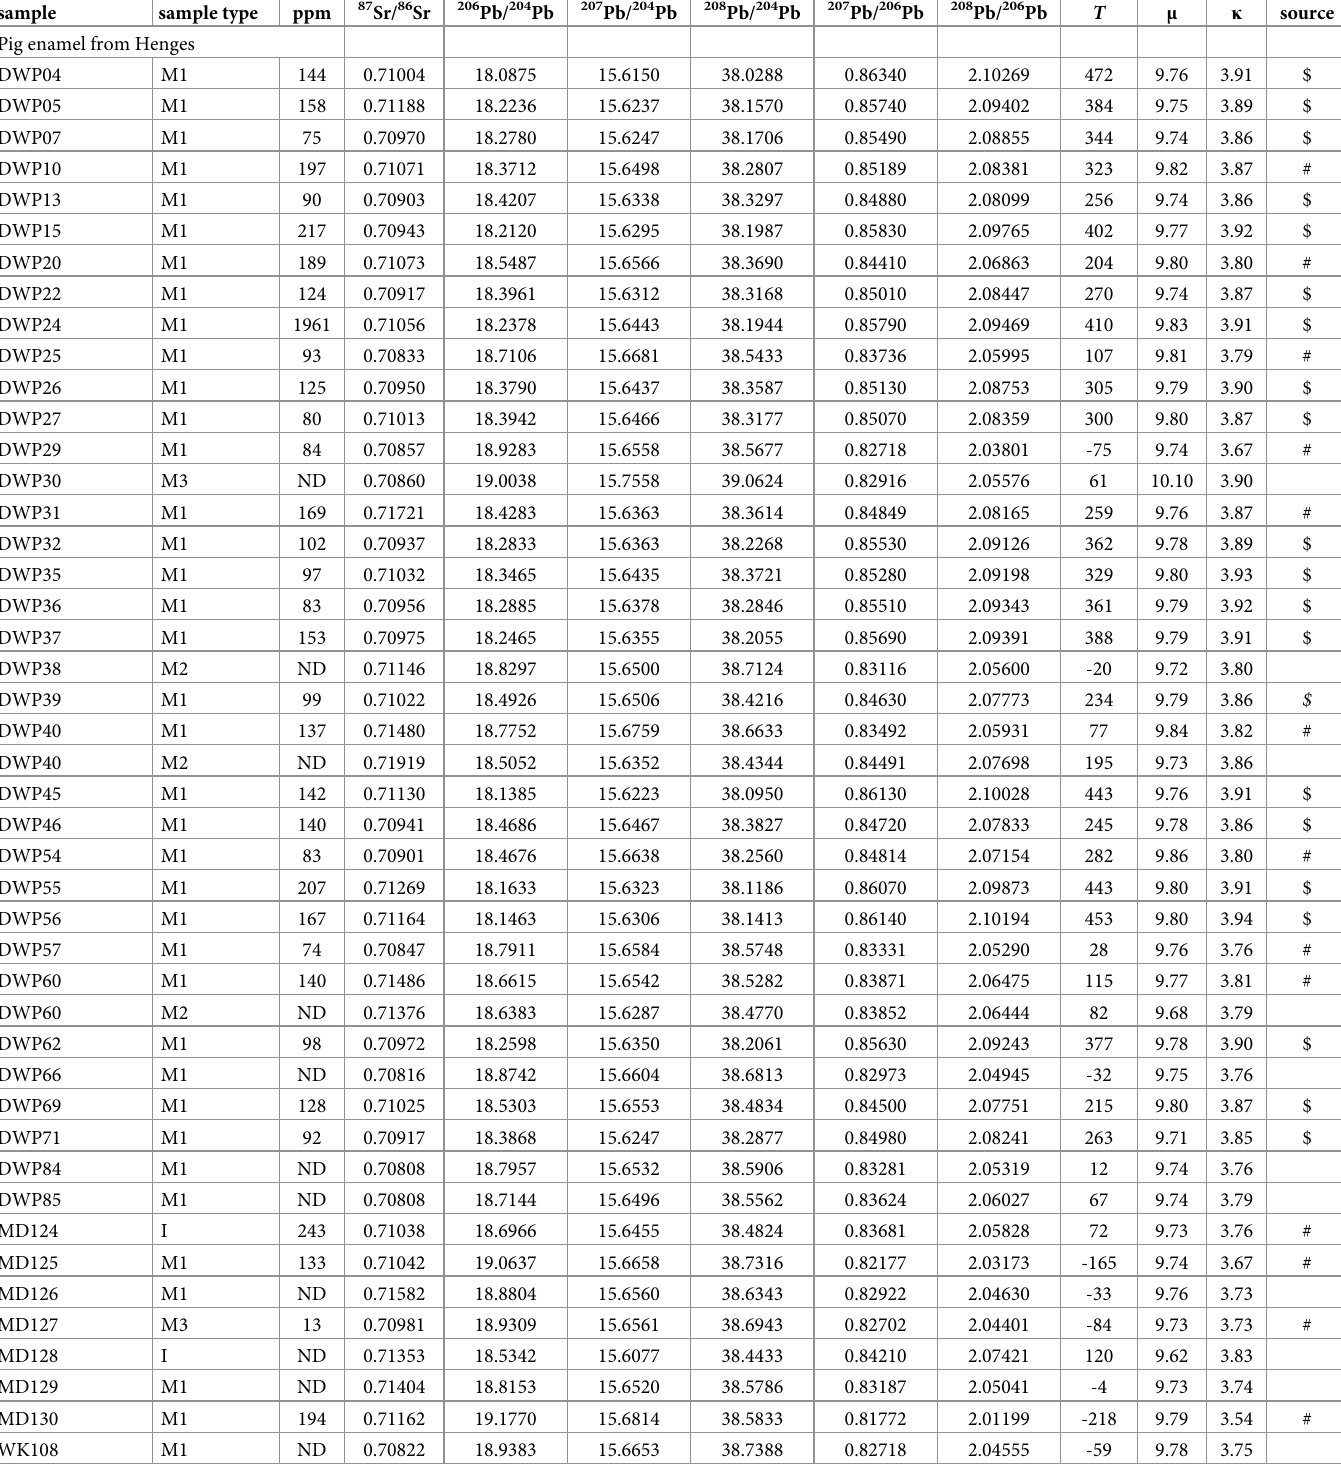
Table 1. Compilation of Pb and Sr isotope data from this study and previously published data. $—previously published Pb data [5], # samples solutions [30] x- sam- ples solutions [35, 36]. Unmarked samples are new analysis from tooth enamel and bone prepared for this study.